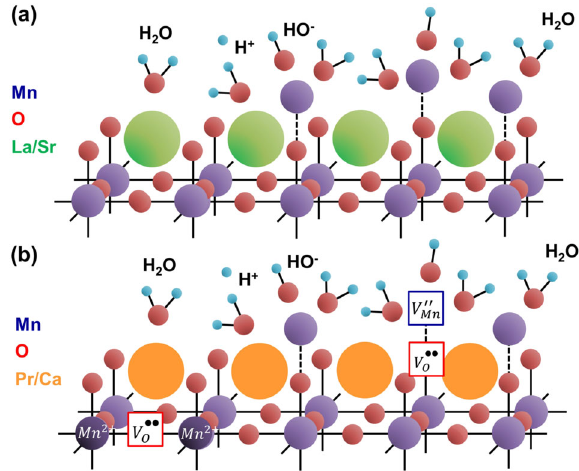
Fig. 7 Schematic representation of a snapshot of the dynamic manganite- H 2 O interface. a For LSMO, the observed reversible Mn-adatom dynamics in liquid H 2 O is connected to the absence of defect reactions and preservation of Mn oxidation state. b In contrast for PCMO, the reduced Mn 2 + species are formed, due to surface and subsurface oxygen vacancy V (cid:1)(cid:1) o